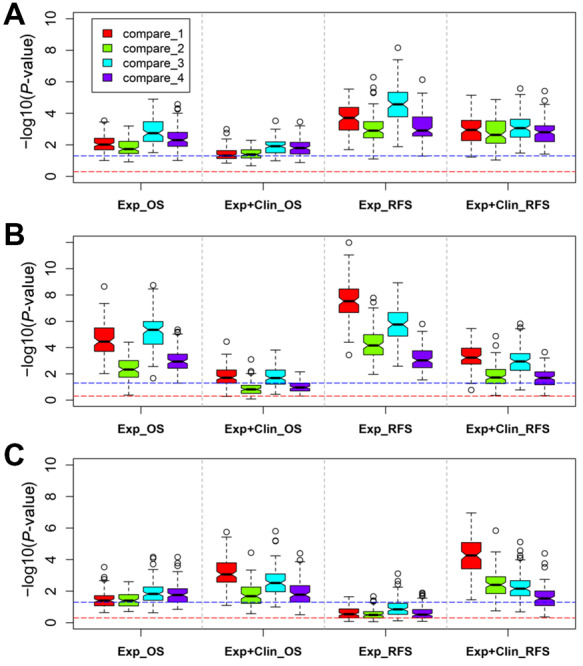
Prognostic effects of the identified gene dysregulations. (A) Results in TCGA CRC dataset. (B) Results in GSE39582 dataset. (C) Results in GSE17538 dataset. X-axis indicates four prognostic models. Exp+Clin_OS: OS cox model fitted with two genes’ expression data and clinical information; Exp_OS: OS cox model fitted with two genes’ expression data; Exp+Clin_RFS: RFS cox model fitted with two genes’ expression data and clinical information; Exp_RFS: RFS cox model fitted with two genes’ expression data. Y-axis indicates negative logarithm of P-value of Wilcox test when examining whether C-indexes of cox models fitted with dysregulations were significantly larger than controls. Each test was repeated 100 times. The blue dashed line indicates negative logarithm of 0.05. The red dashed line indicates negative logarithm of 0.5. compare_1, compare_2, compare_3, and compare_4 represent four types of control settings. compare_1: two genes were randomly selected from the gene list of preprocessed expression data; compare_2: one DEG and one non-DEG were randomly selected from the gene list of preprocessed expression data; compare_3: one regulation was randomly selected from the reference GRN; compare_4: one regulation whose target is DEG was randomly selected from the reference GRN.